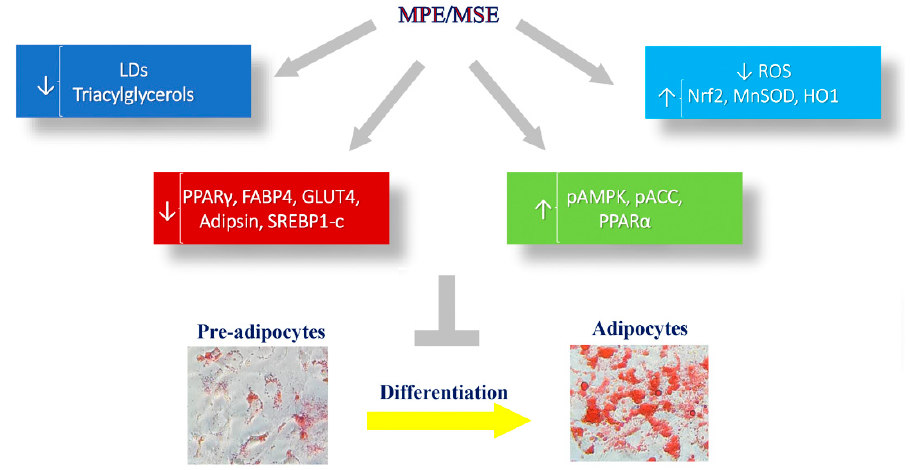
Figure 8. The addition of MPE and MSE to the differentiation medium reduced 3T3-L1 adipocytes differentiation, as demonstrated by the loss of LDs and TGs. The anti-adipogenic and anti-lipogenic effects of MPE and MSE seem to be correlated with the ability of mango extracts to reduce PPAR γ and SREBP-1c and their targets, as well as to increase AMPK and PPAR α . MPE and MSE also reduce ROS content produced during adipocyte differentiation, by activating Nrf2 and its downstream tar- gets.